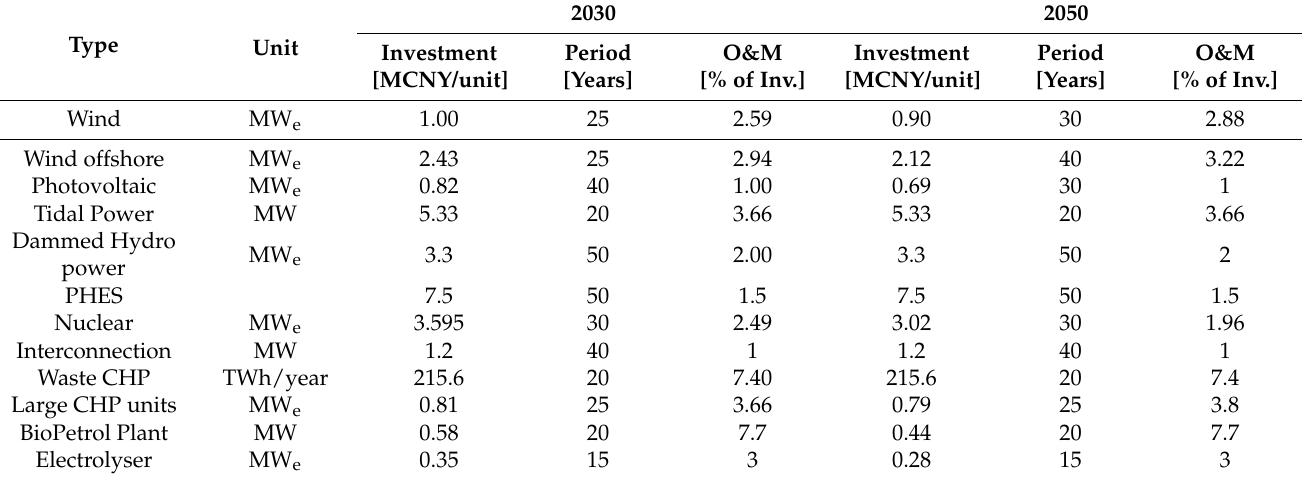
Table 8. Costs of energy investment and fixed O&M for renewable technologies and nuclear plants in 2030 and 2050